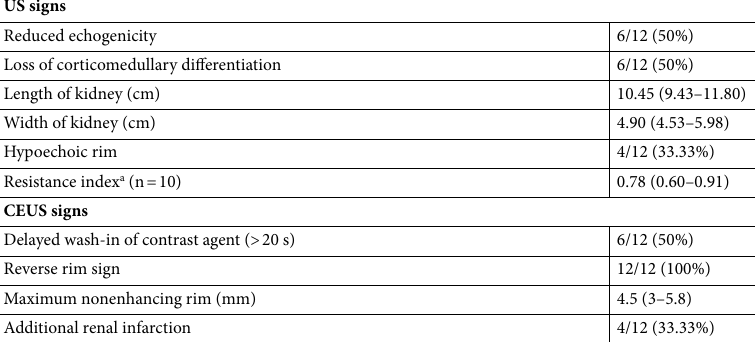
Table 2. US and CEUS findings in 12 patients with RCN. Continuous variables are given as median (IQR), categorical variables as absolute/total numbers (n/N) and percentages in brackets. US denotes ultrasound, CEUS contrast-enhanced ultrasound, RCN renal cortical necrosis. a Eleven patients with available data, while one patient had no measurable RI